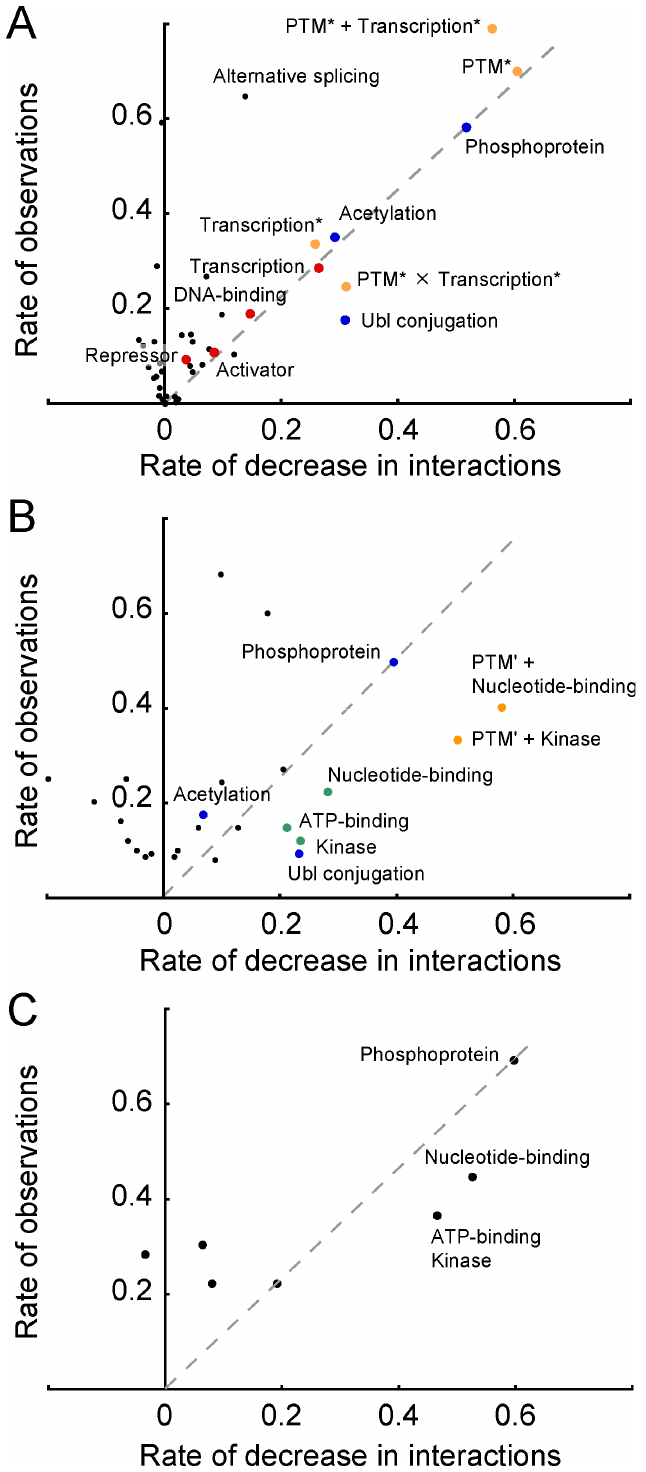
Fig 3. Scatter plot of the decrease in the average number of interactions after eliminating the proteins with the corresponding keyword, and the number of eliminated entries. The horizontal and the vertical data are the rates normalized by the original average number of interactions (for NCP: 9.75) and the total number of entries (for NCP: 1,120). A. NCP. The keywords related to post-translational modifications